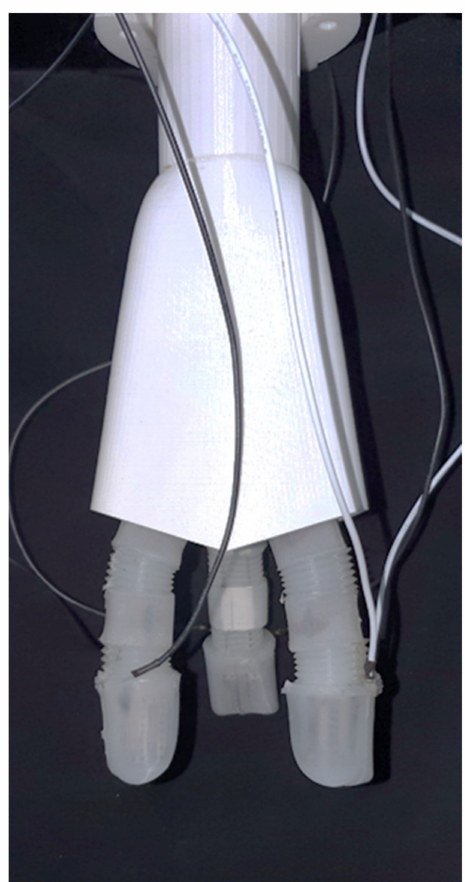
Figure 21. The final prototype of the soft gripper with applied EGaIn soft